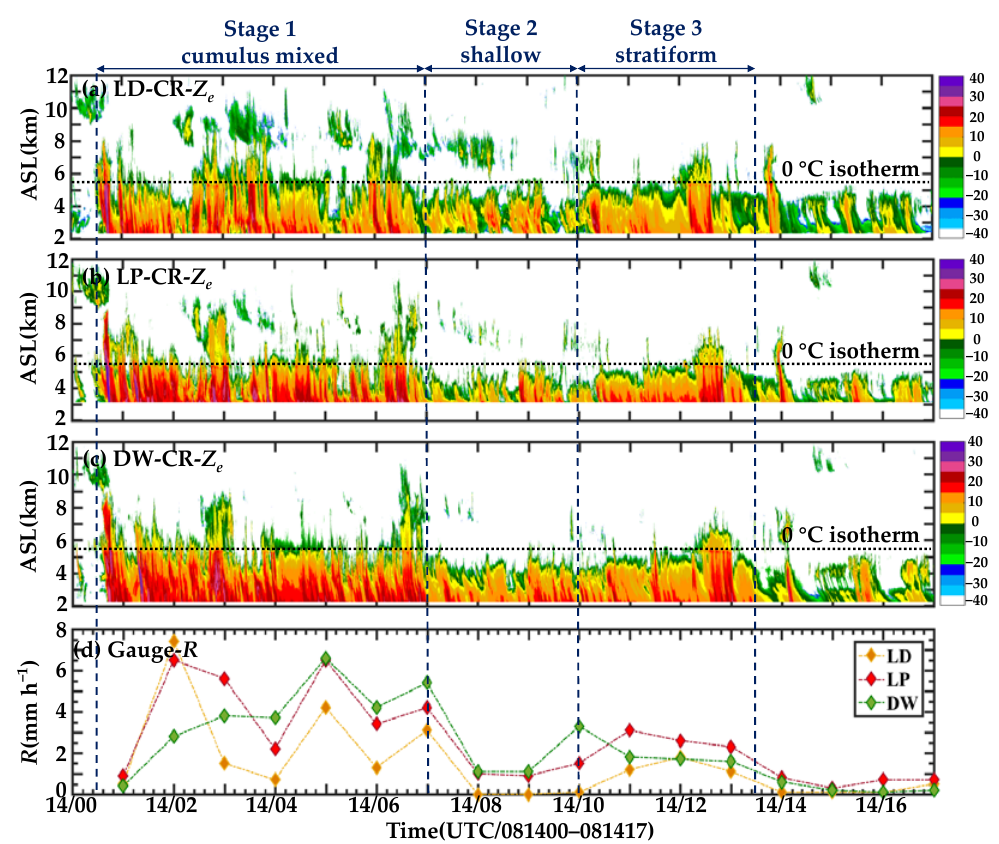
Figure 4. Time-height cross-sections of equivalent reflectivity factor ( Z e , dBZ), measured by the CR, and ground rain rate ( R , mm h −1 ), measured by the OTT, over three topographic sites for the mixed cloud and precipitation process on 14 August 2020; ( a – c ) represent Z e s at the LD, LP, and DW sites, respectively. The black dotted line denotes the 0 °C isotherm at about 5.4 km, ASL, and ( d ) represents ground hourly Rs .